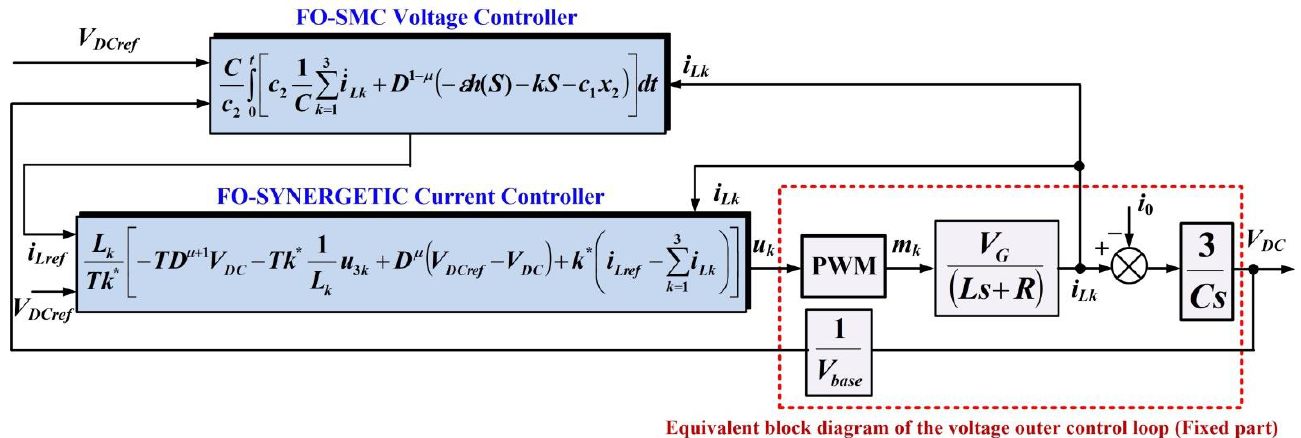
Figure 11. Block diagram modeled using the transfer function for the control system of the power electronic converter using an FO SMC controller for the voltage outer control loop and an FO synergetic controller for the current inner control loop.